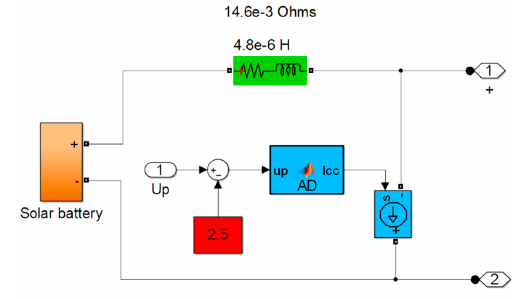
Figure A5. Model of solar panel No. 2 with analog equivalents of a pulse-width modulator and a shunt switch.